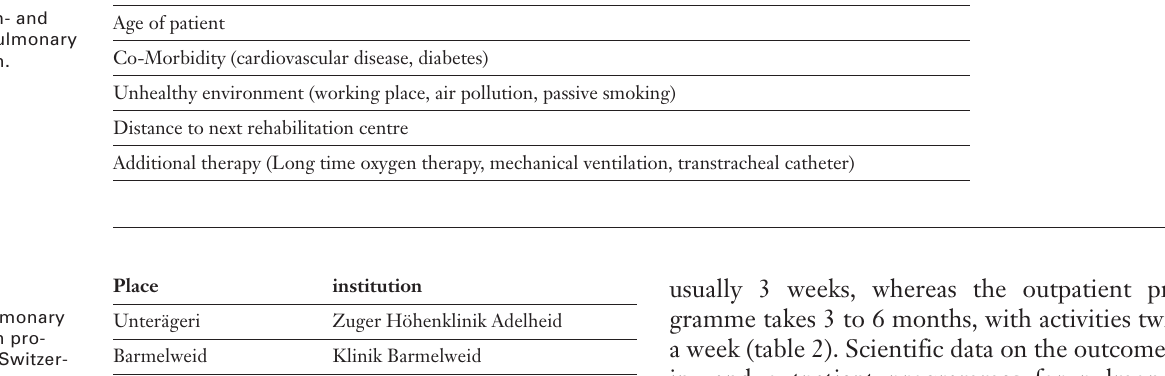
Inpatient pulmonary rehabilitation pro- grammes in Switzer- land